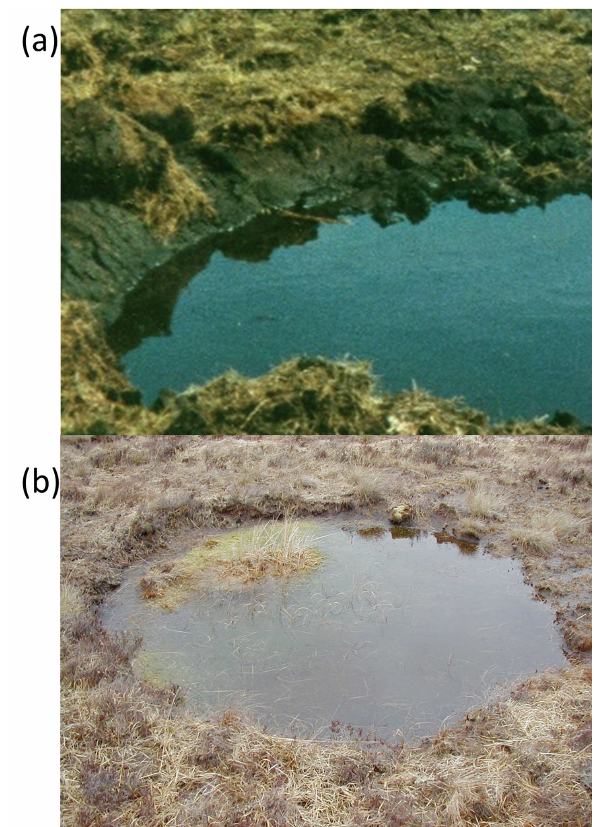
Figure 5. ( a ) Photograph of the crater soon after the event in 1985 illustrate good agreement in the actual and simulated profile of crater sides. ( b ) Photograph of the crater in March 2005 showing the full diameter and circularity before excavation.